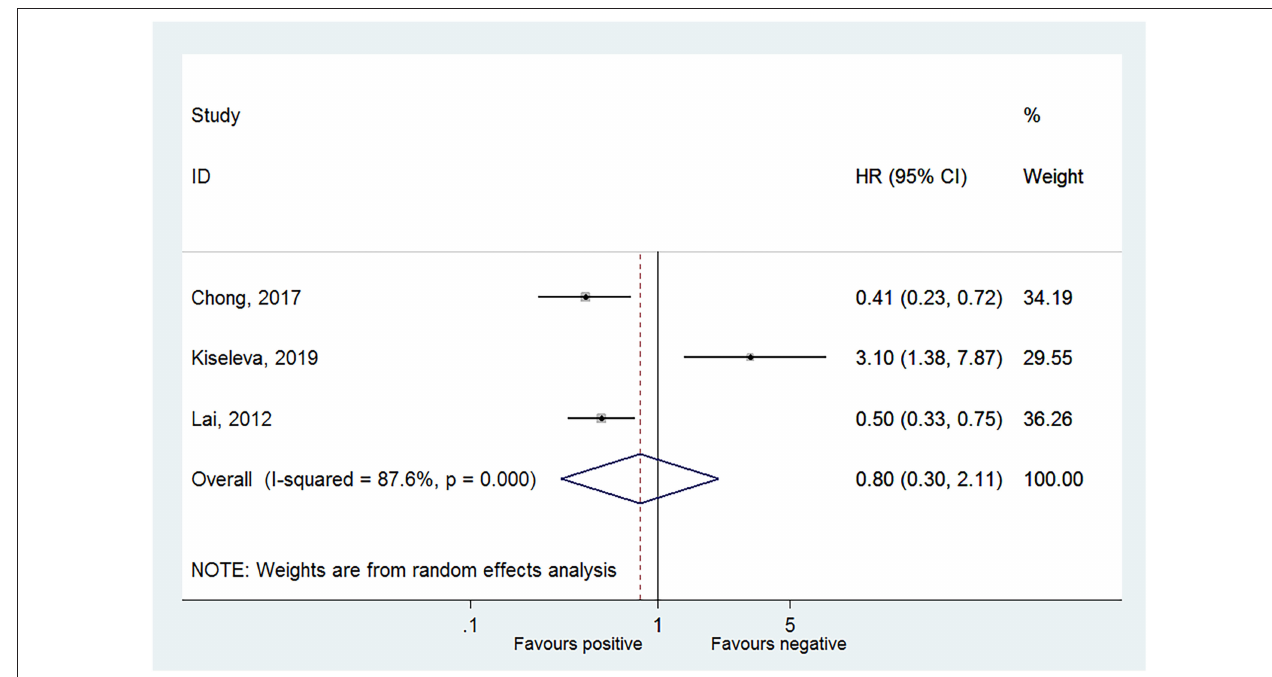
FIGURE 3 | Forest plot of disease-free survival comparing the human papillomavirus subtype 16 (HPV-16) positive vs. negative groups.